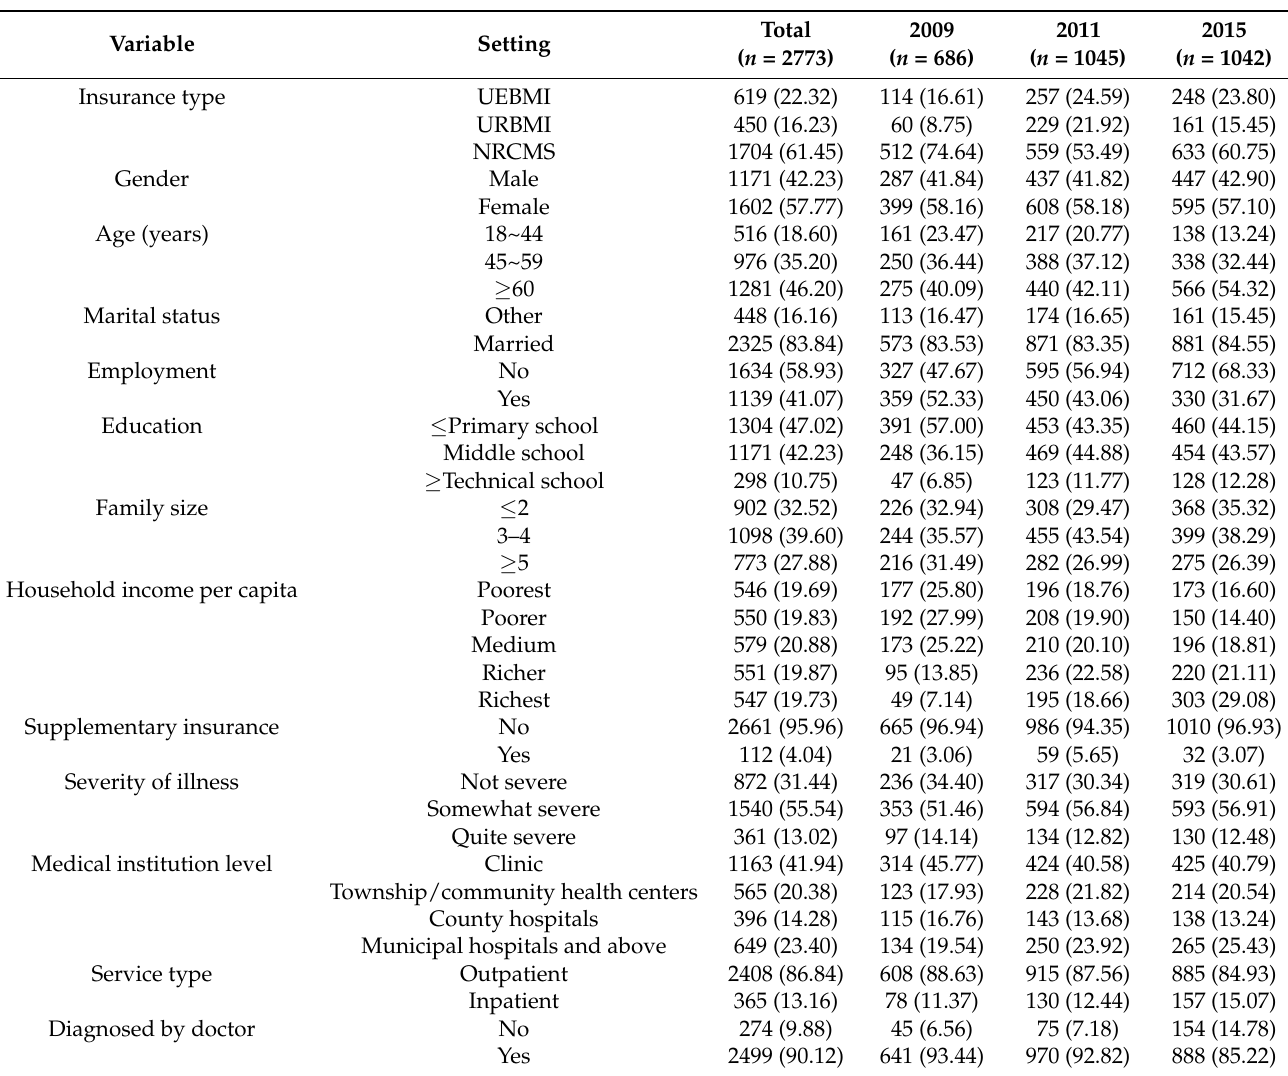
Table 2. Characteristics of participants [ n